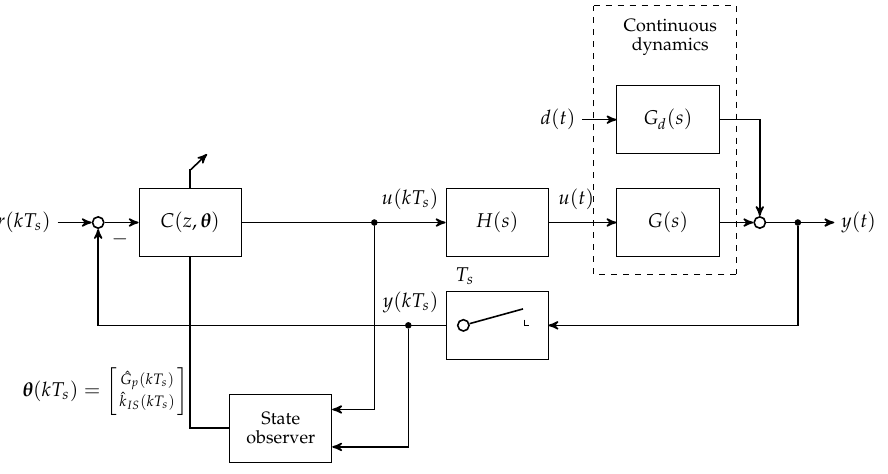
Figure 8. Block diagram of the discrete disturbance rejection controller C ( z , θ ) implementation with gain scheduling depending on estimated process parameters insulin sensitivity ˆ k IS ( kT s ) and blood glucose concentration ˆ G p ( kT s )